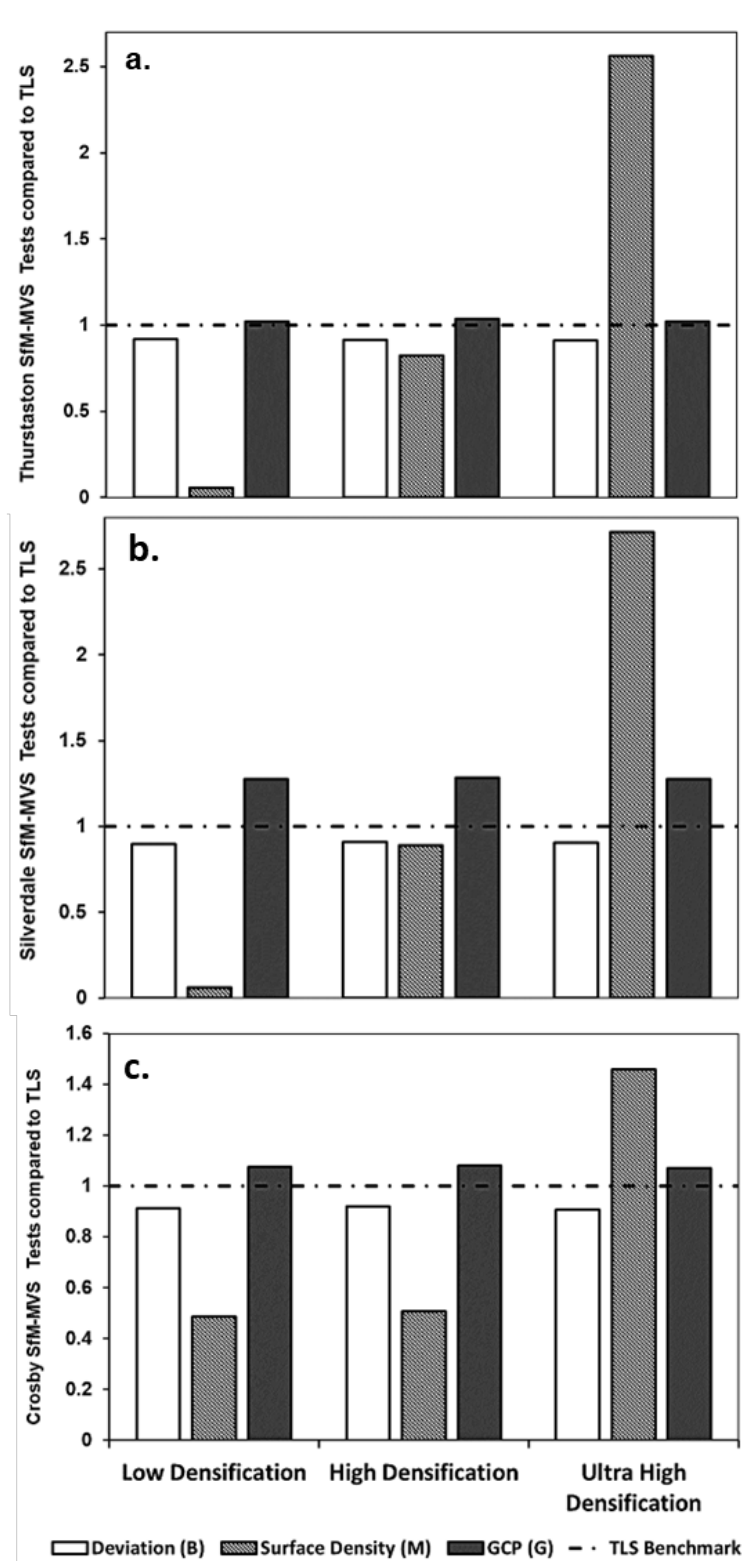
Figure 8. Results of the three comparative tests (Deviation, Surface Density, GCP) compared to the TLS reconstruction benchmark for ( a ) Thurstaston ( b ) Silverdale and ( c ) Crosby. Reconstruction accuracies of SfM-MVS and the TLS for each site and densification parameter. A result of 1 would imply that SfM-MVS and the TLS were equivalently accurate.